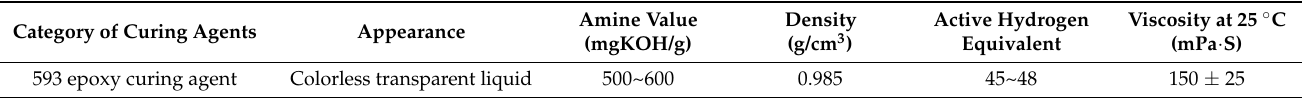
Table 3. Material properties of liquid phenolic resin.